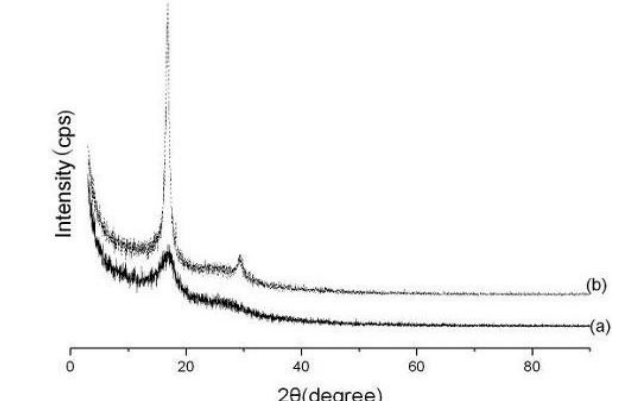
Figure3. X -ray diffraction patterns for the nanofibers: (a) as-spun; (b) hot-stretched.